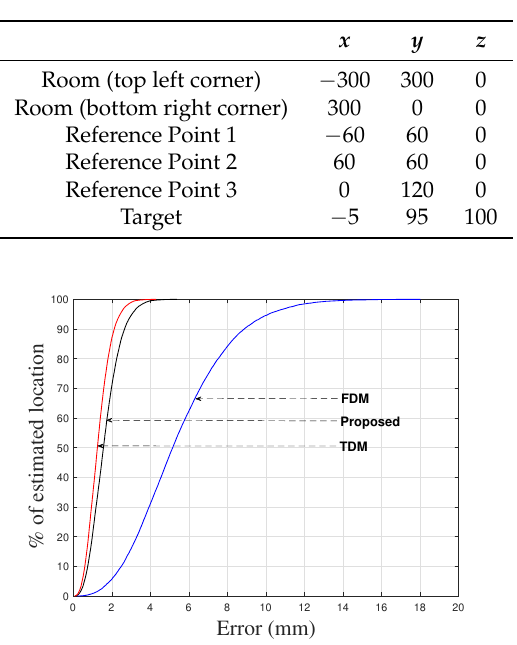
Figure 4. Cumulative absolute location errors (from simulations) of target (receiver) obtained for the proposed, TDM and FDM